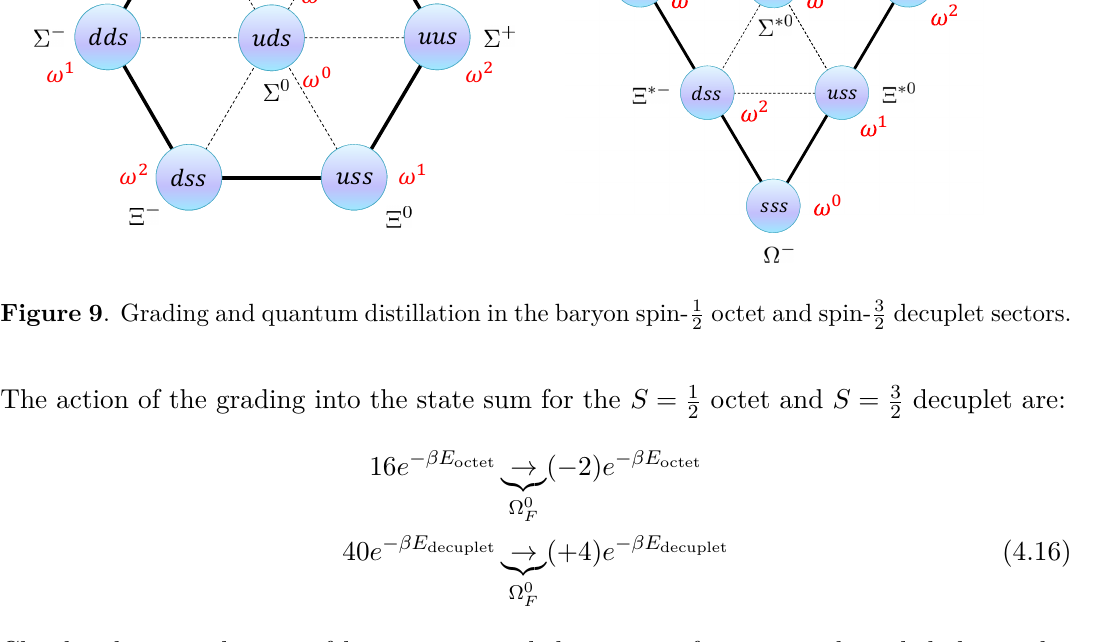
octet and S = 3 decuplet 2 2